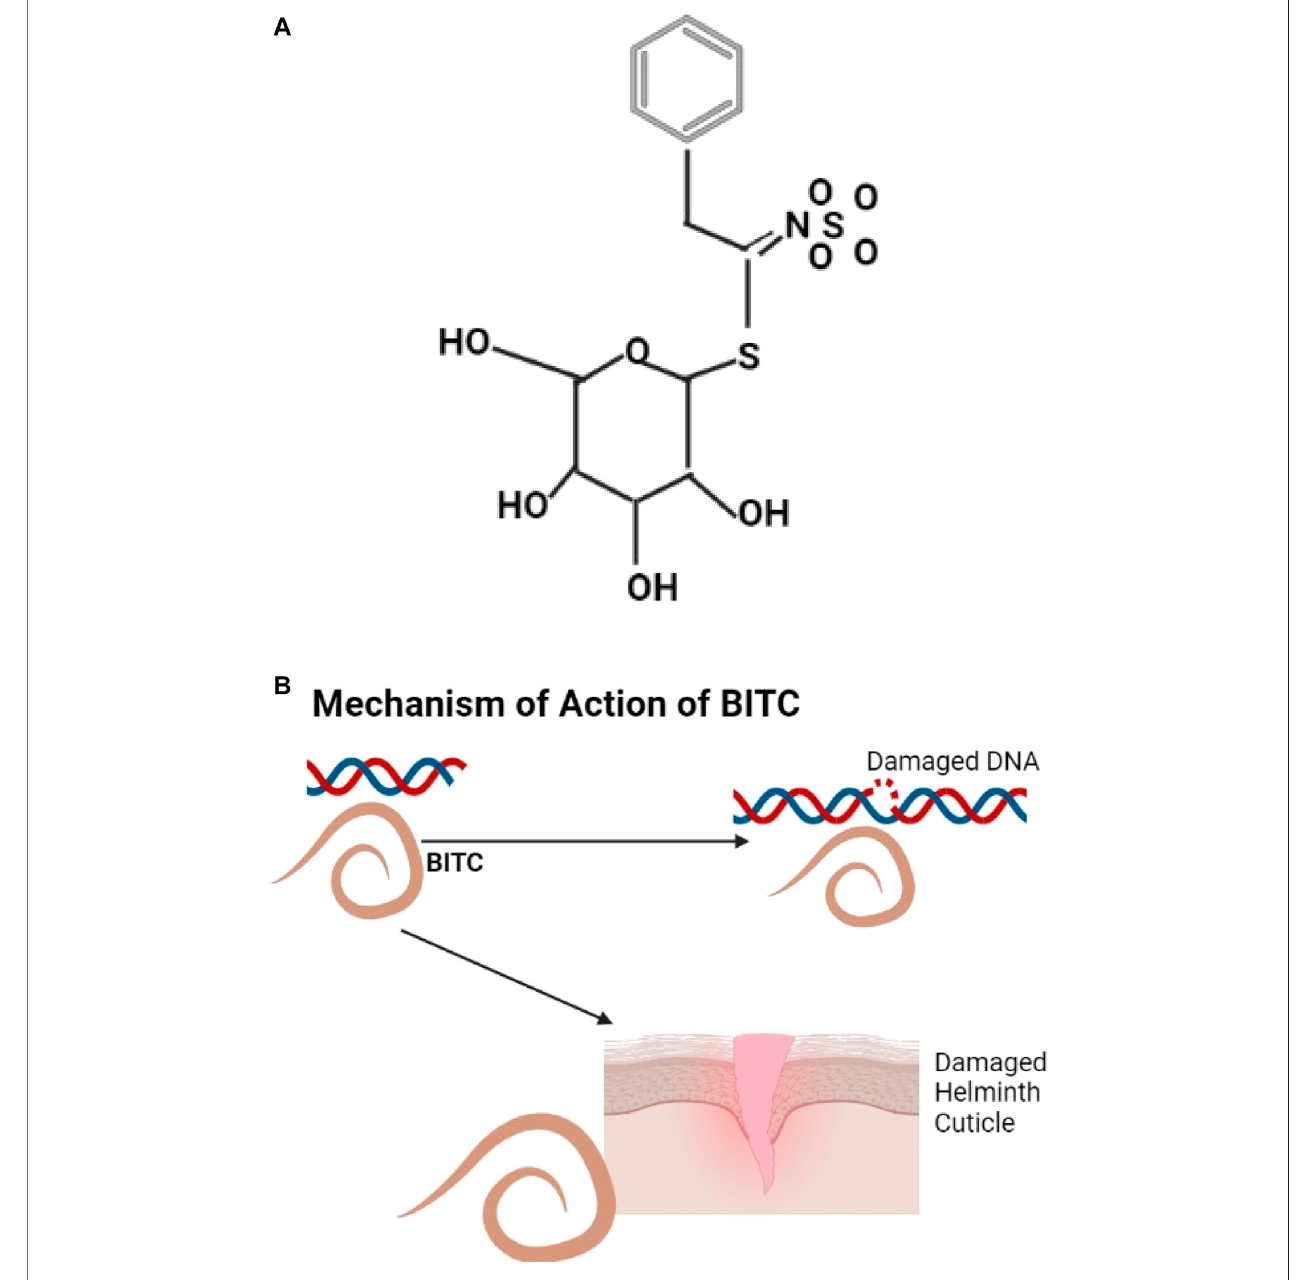
FIGURE 5 | (A) The structure of Benzyl glucosinolate, metabolites of glucosinolates (Akram et al., 2021). (B) BITC causes helminth DNA and cuticle damage.